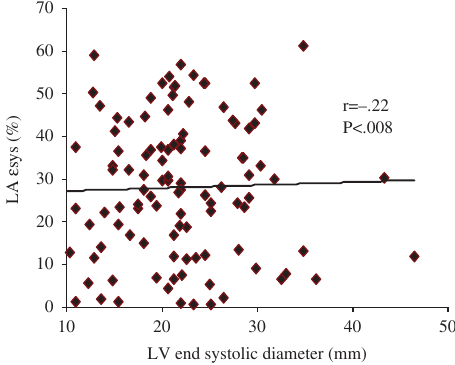
Figure 4. Global LA systolic strain ( e sys) and LV end systolic diameter in